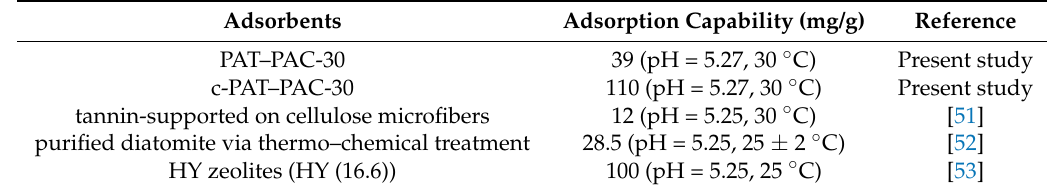
Figure 10. Dye adsorption of carbon monoliths. SY is sunset yellow, CR is congo red, MB is methylene blue, and MV is methyl violet. Table 5. The comparison of adsorbent toward methylene blue adsorption reported from the literature.